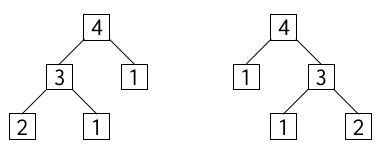
Fig. 3: Partition Trees for Algorithm (a) and (b) for WHT